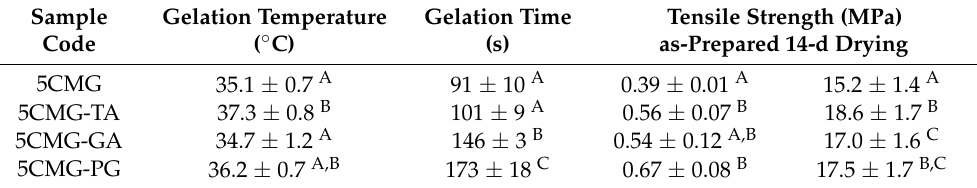
Table 2. Polyphenol effect on gelation temperature, gelation time and tensile strength of 5CMG